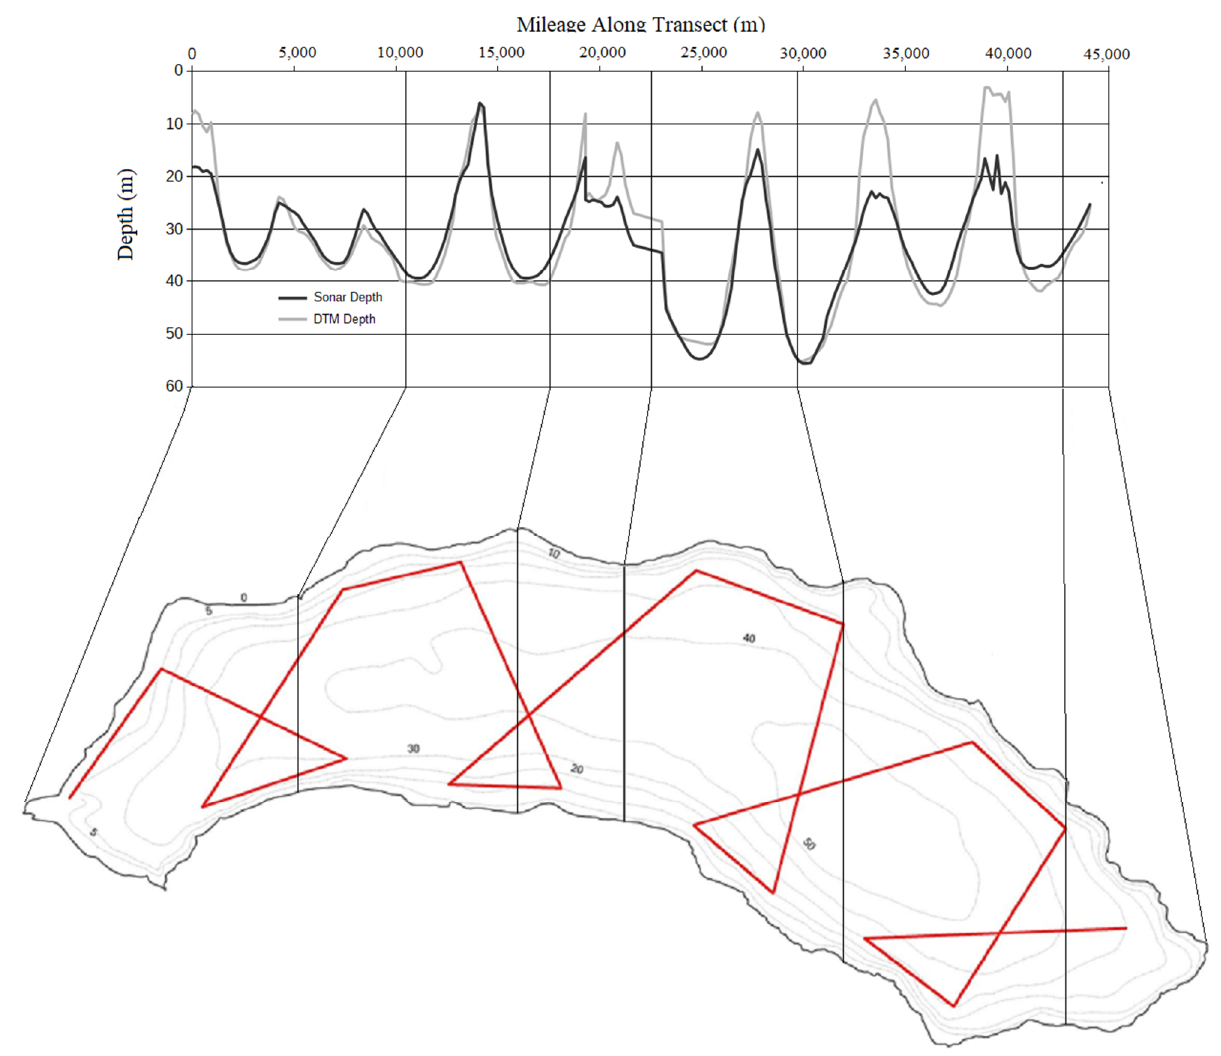
Figure 20. Measured depth comparison between SONAR and DTM along transect. Table 6. Results and statistics for surface fits for ( h DTM − h SONAR ).